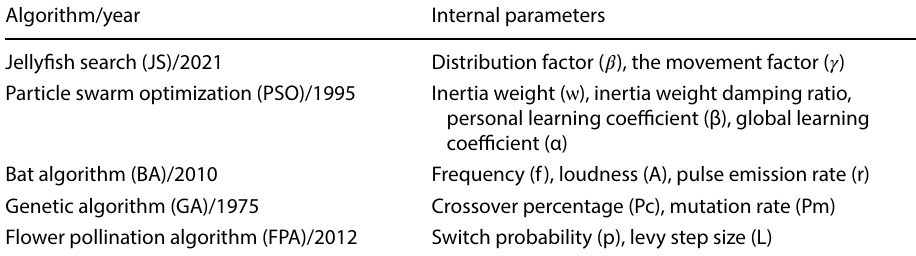
Table 1 The value of internal parameters for some nature- inspired algorithms